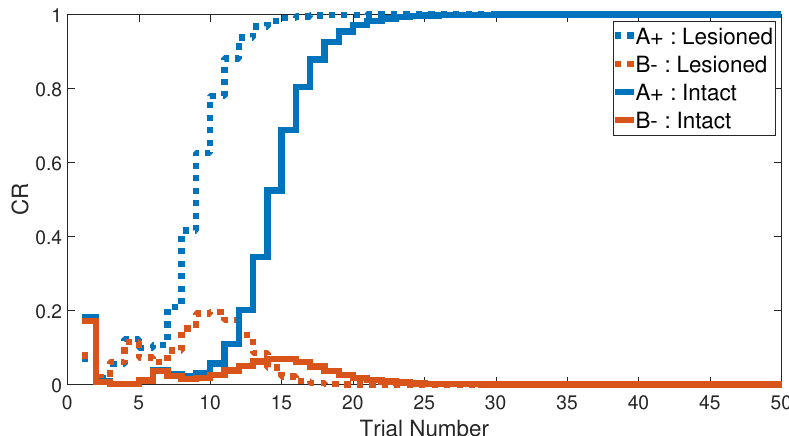
Figure 8. Stimulus discrimination learning <A+, B − > for both intact and lesioned systems of CHCQ